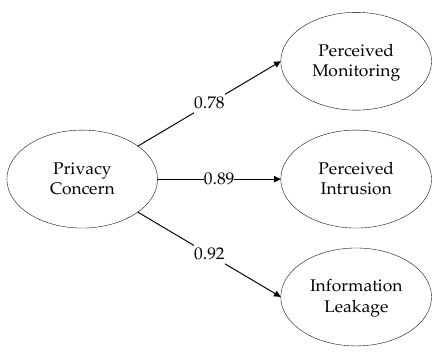
Table 5. Structural model relationships obtained.